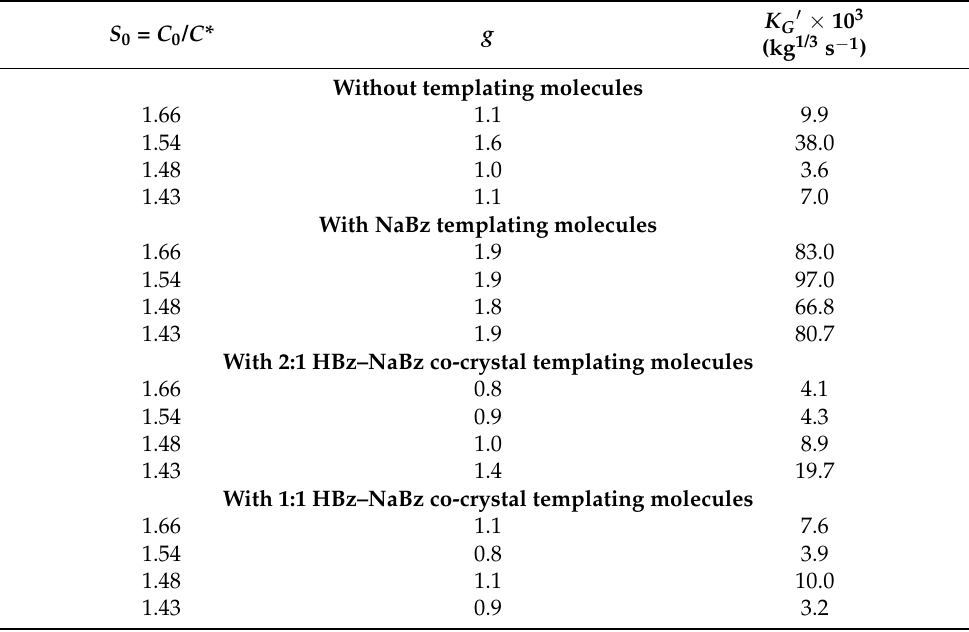
Table 3. Order of crystal growth kinetics ( g ) and coefficient K G (cid:48) of 2:1 HBz–NaBz co-crystallization at different initial degrees of supersaturation ( S 0 ) with and without templating molecules.